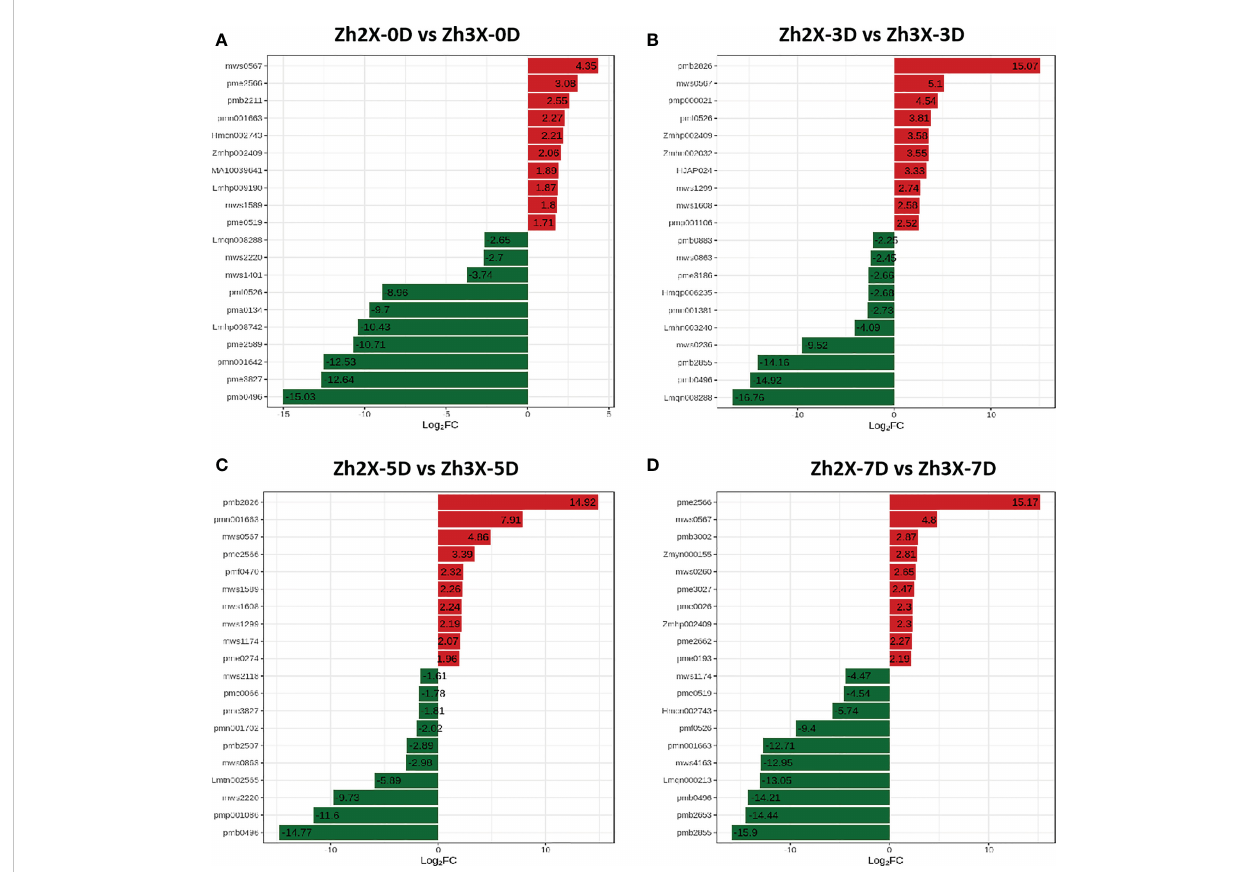
FIGURE 9 TopFC metabolites in each comparison group at different days post fl ooding. (A) Zh2X-0D vs 347 Zh3X-0D, (B) Zh2X-3D vs Zh3X-3D, (C) Zh2X-5D vs Zh3X-5D, (D) Zh2X-7D vs